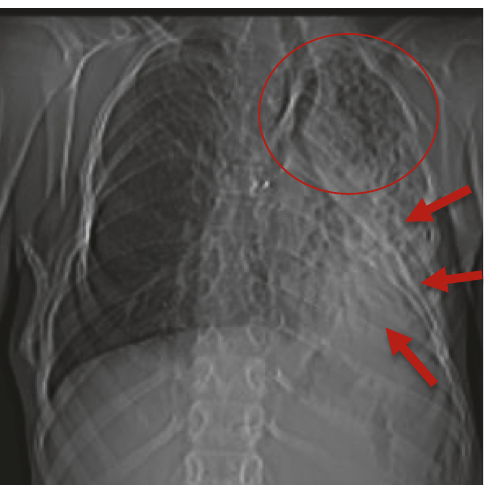
Figure 2: Frontal chest x-ray showing an atelectasis of the left lower lobe (red circle) with alv´eolo-interstitial pneumopathy on the homolateral upper lobe (red